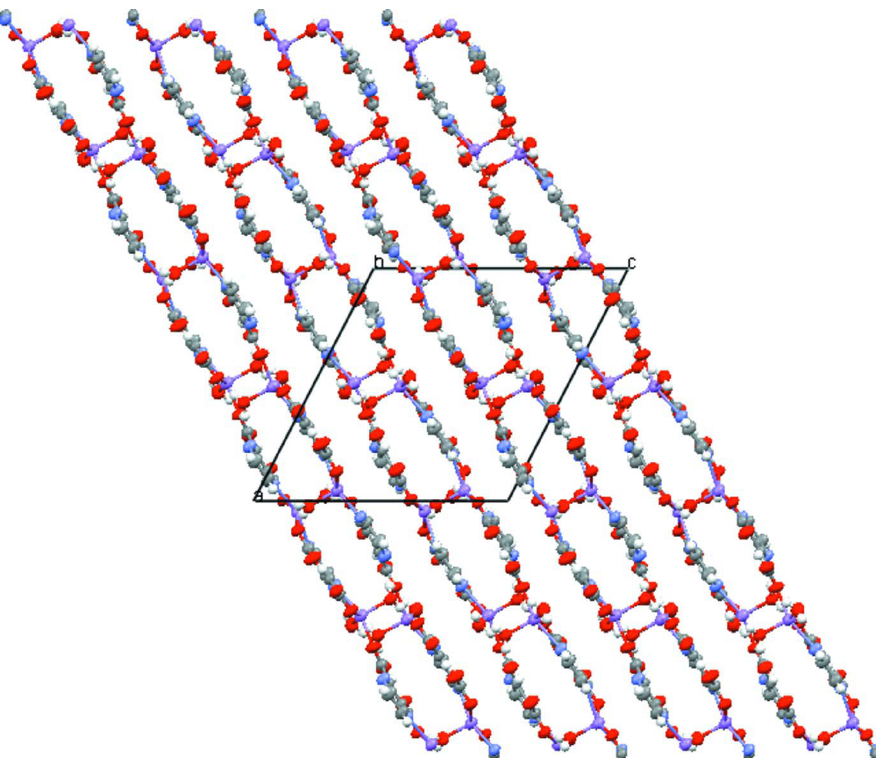
Figure 2 View of the stacking structure of (I) within the unit cell, down the b axis. Poly[triaquabis( µ -3-carboxypyrazine-2-carboxylato)dilithium(I)] 2 Crystal